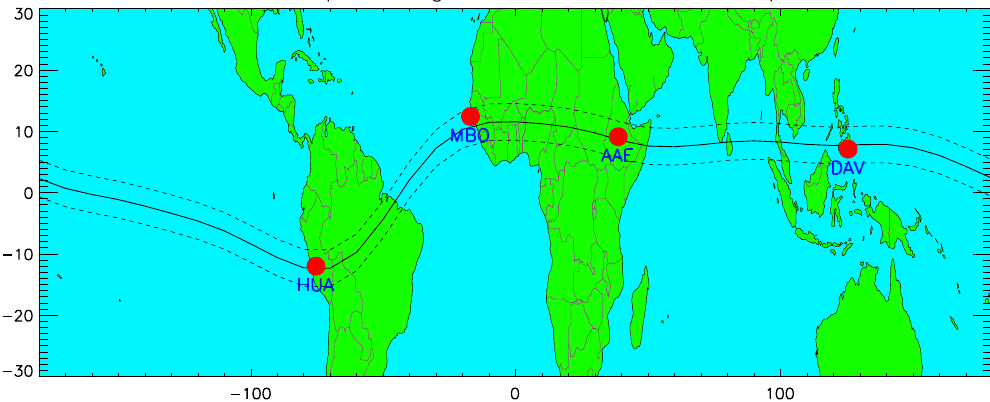
Figure 1. Geographic location of the ground-based magnetometers used for this study. The solid horizontal line depicts the geomagnetic equator, and the two dashed lines indicate the equatorial electrojet